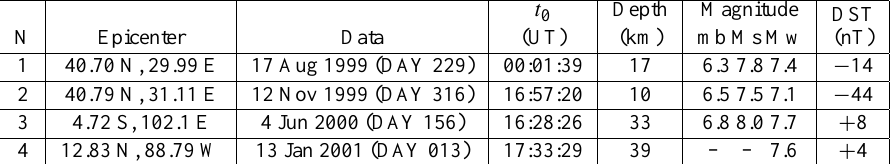
Table 1. General information about earthquakes